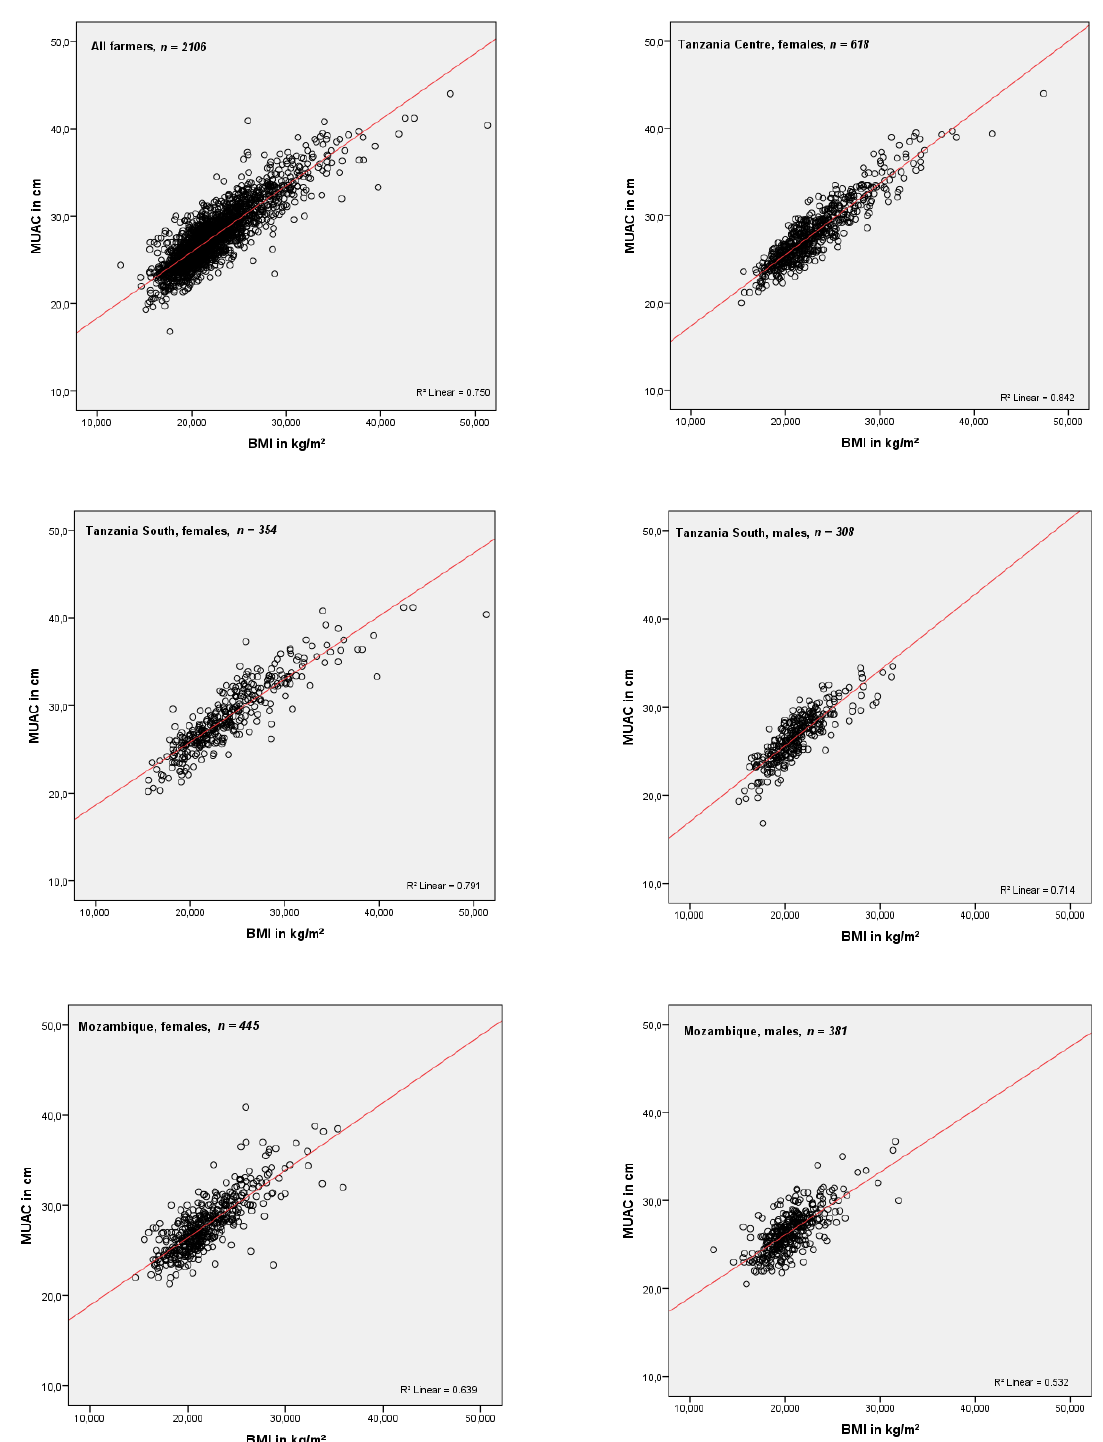
Figure 2. Association of mid-upper arm circumference (MUAC) with body mass index (BMI) in farmers and the respective sub-groups by sex and region.